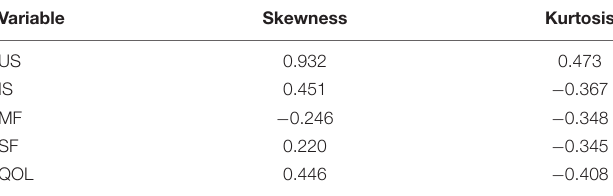
TABLE 4 | Normality analysis using Skewness and Kurtosis values.